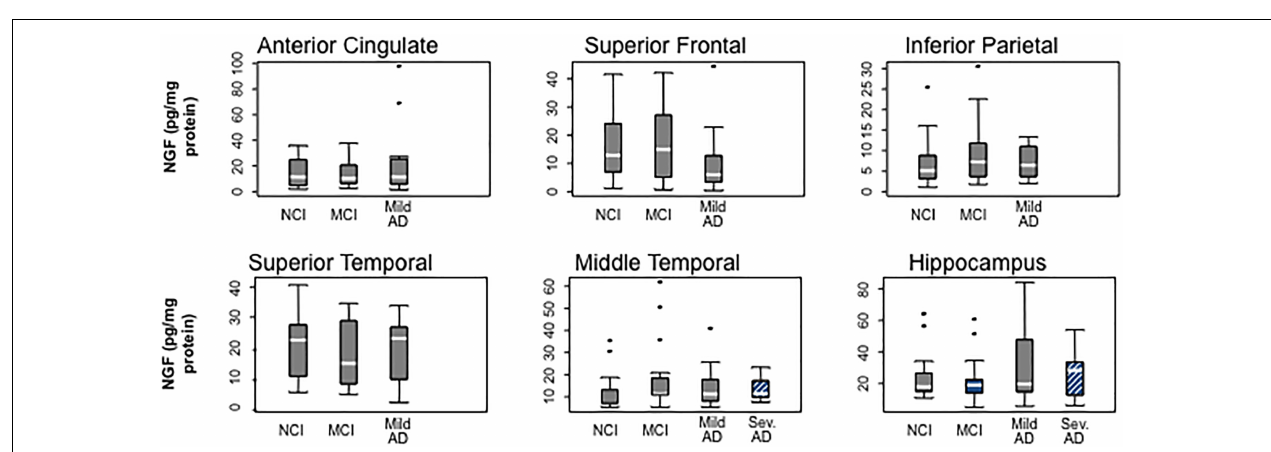
FIGURE 4 | Box plots showing the stability of NGF protein levels with the cortex and hippocampus during the progression of AD. Reproduced from Mufson et al.